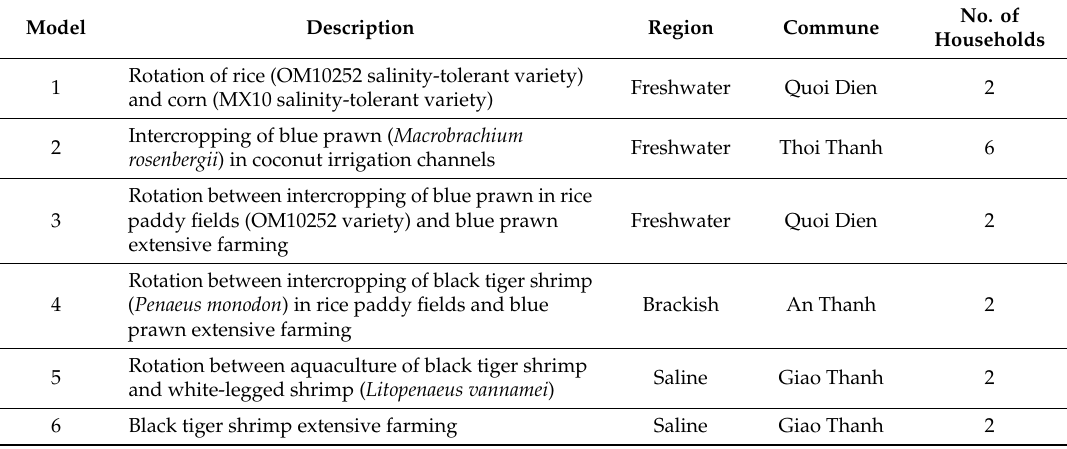
Table 1. Sampling labels in arable areas.